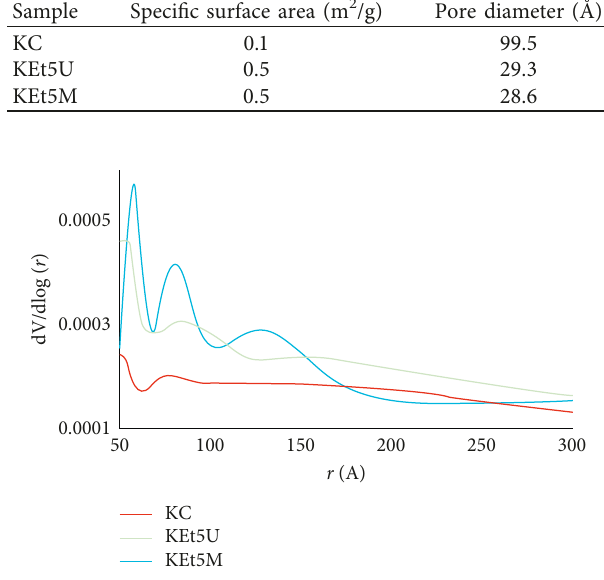
Figure 8: Pore distribution of the KC (a), KEt5US (b), and KEt5M (c)